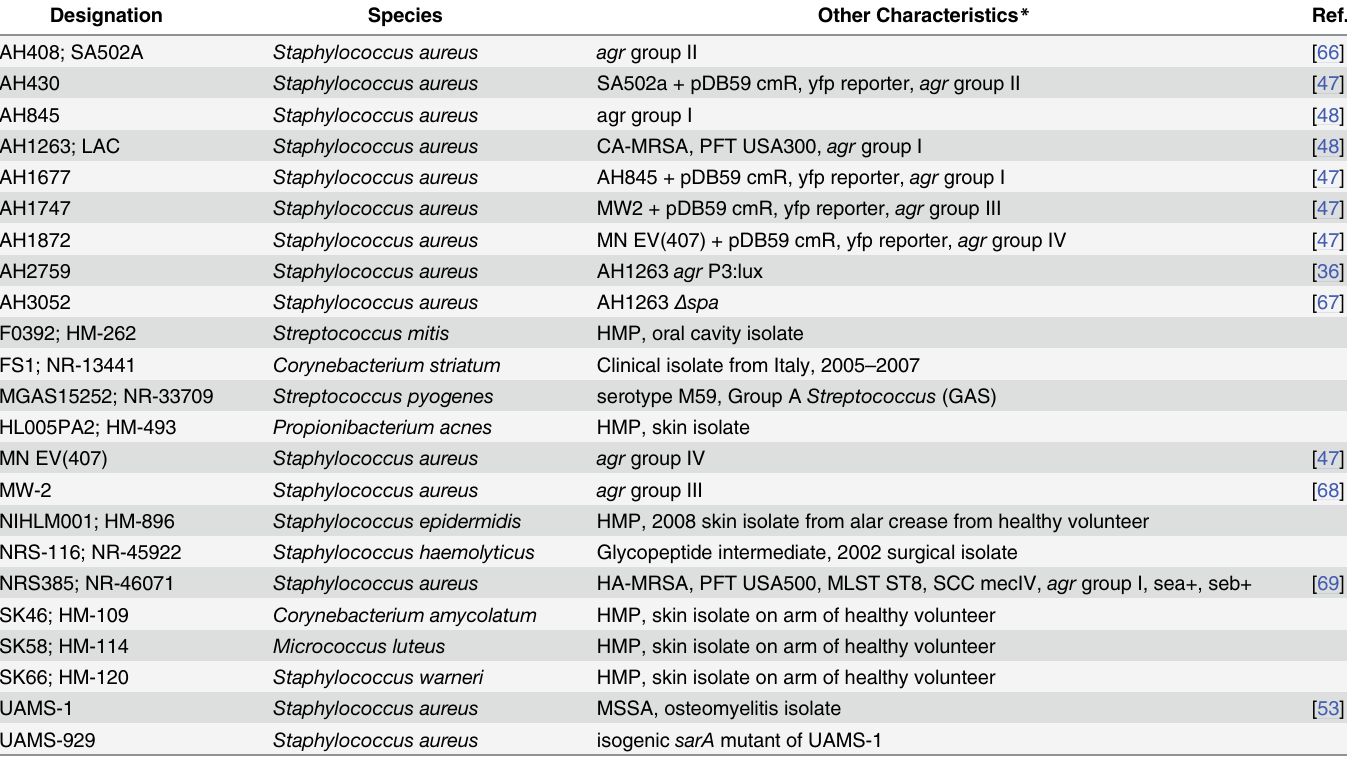
Table 1. Escherichia coli cultures were grown in Luria-Bertani (LB) broth or on LB agar plates Table 1. Description of bacterial strains and plasmids used in this study. Other Characteristics *